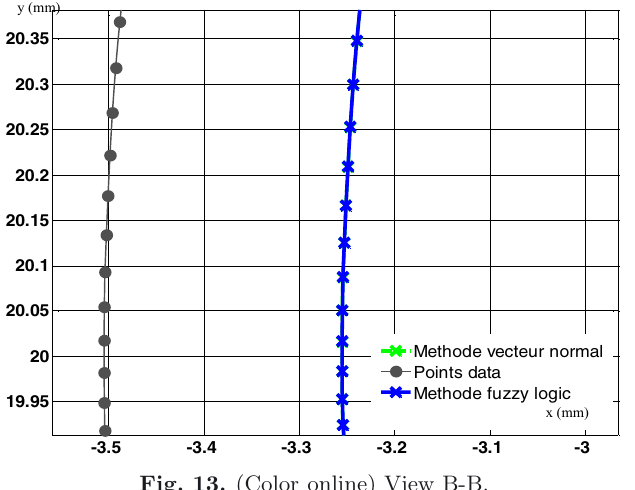
Fig. 13. (Color online) View